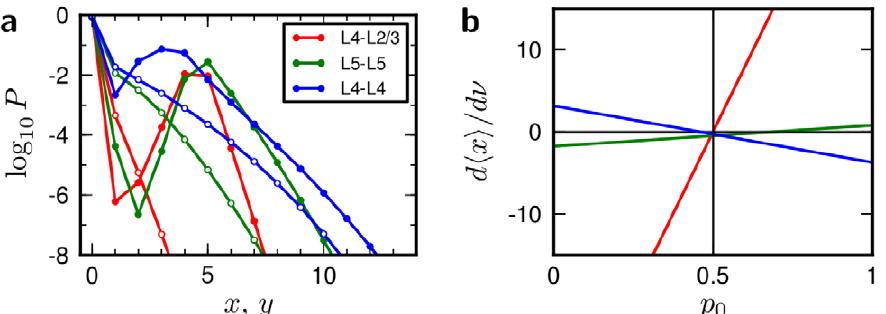
Figure 4. Further properties of the single connection models. a : Marginal probabilities of active ( x , filled circles, eq. 15) and inactive ( y , empty circles, eq. 16) synaptic contact numbers of the best-fit models shown in Fig. 1. b : Derivative of the number of active synaptic contacts by the neuronal firing rate as a function of the baseline correlation p 0 – values of the h m and h s are shifted to keep the equilibrium distribution unchanged for all values of p 0 (27). Negative values indicate a stable equilibrium (firing rate homeostasis). Colors as in a